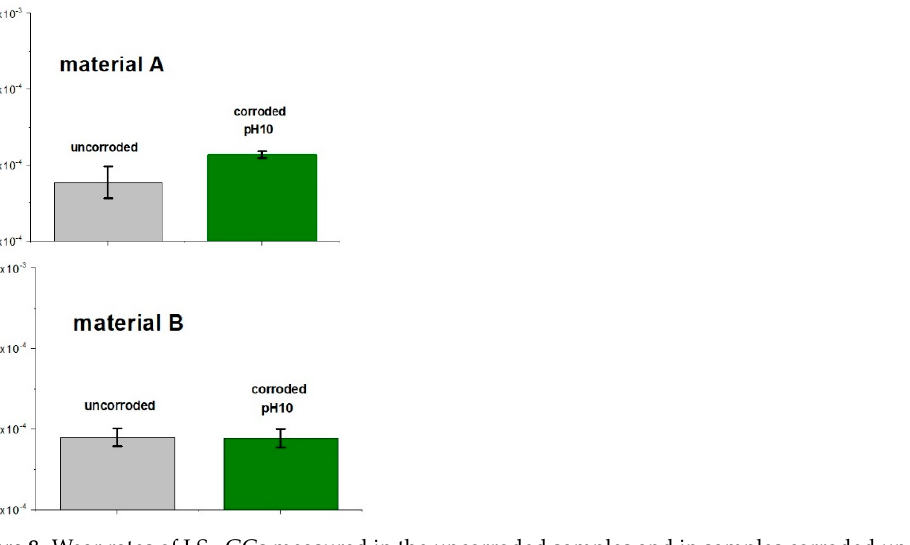
Figure 8. Wear rates of LS 2 -GCs measured in the uncorroded samples and in samples corroded under dynamic conditions in NaOH solution for material A and material B.